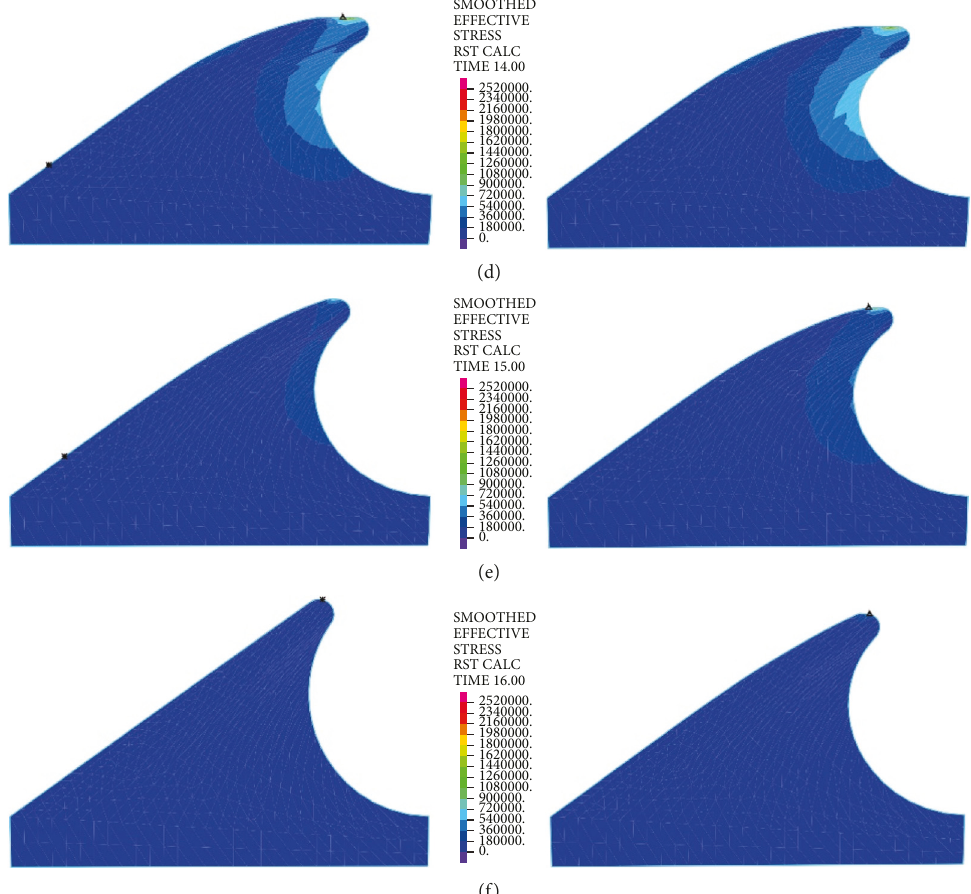
Figure 13: Effective stress distribution of the rubber rings before optimizing during anticlockwise rotation. (a) Deflection 0.2 ° . (b) Deflection 0.4 ° . (c) Deflection 0.6 ° . (d) Deflection 0.8 ° . (e) Deflection 1.0 ° . (f) Deflection 1.2 °